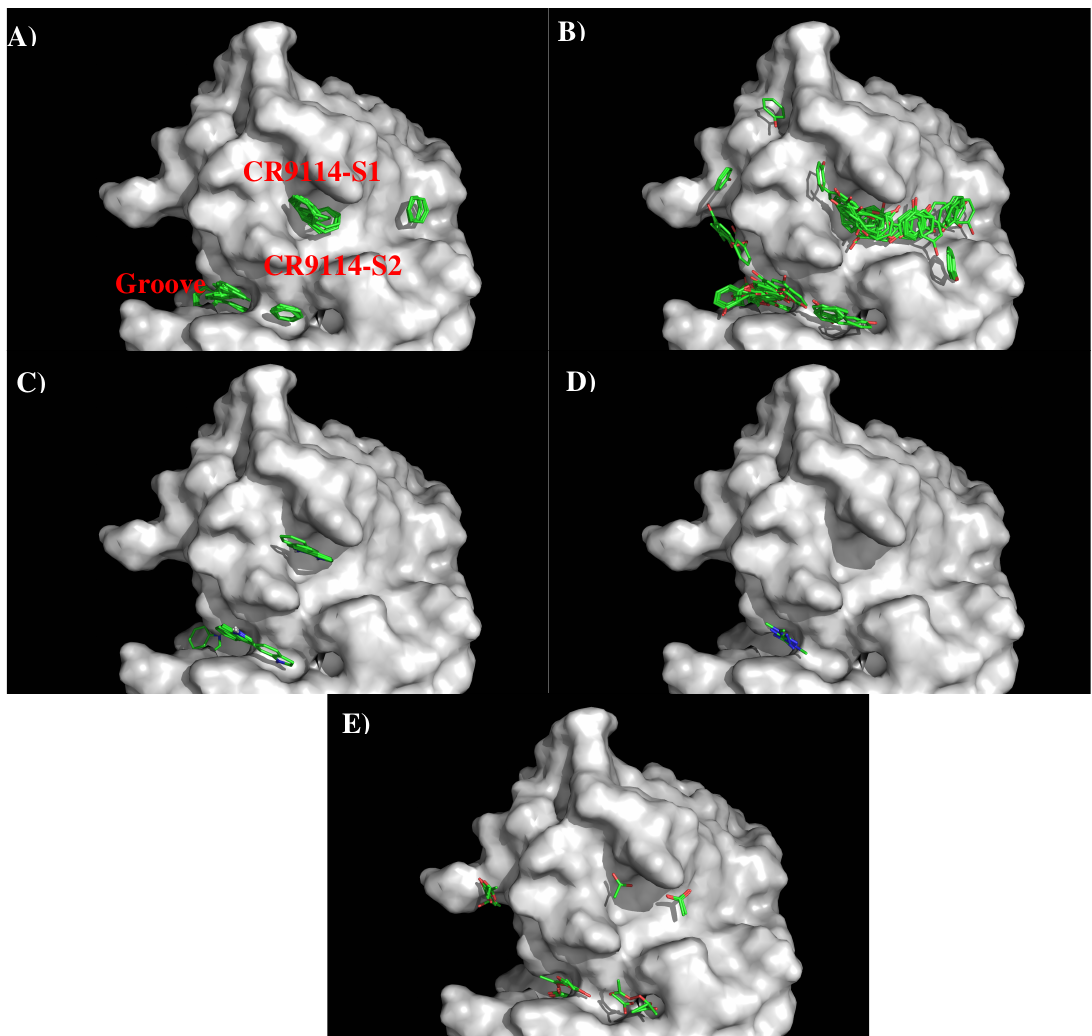
Figure 5. Selected MCSS minima of functional groups on the surface of antibody CR9114. ( A ) BENZ; ( B ) PHEN; ( C ) INDO; ( D ) MGUA; ( E ) ACET. Figures were prepared using PyMOL